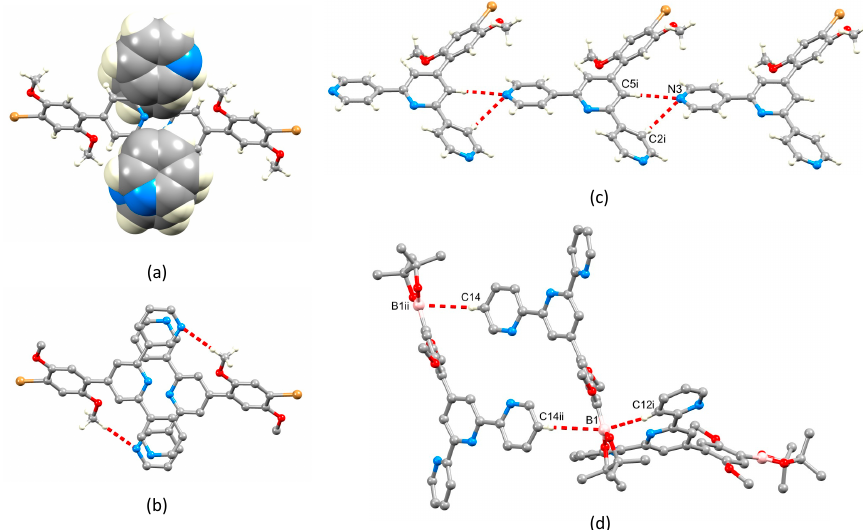
Figure 5. ( a ) and ( b ) Packing of molecules of 3 : ( a ) face-to-face π -stacking of pyridine rings, and ( b ) C–H...N hydrogen bonds within the same structural motif as that shown in part ( a ). ( c ) Bifurcated hydrogen bonding interactions in 4 ; symmetry code i = x , y , –1 + z . ( d ) C–H…B1 contacts in the